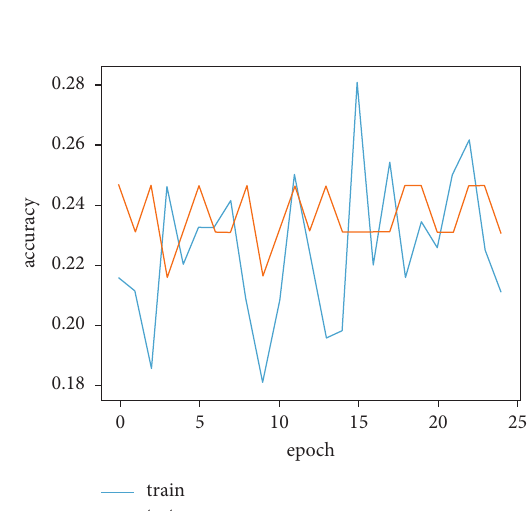
Figure 11: Inception_V3.